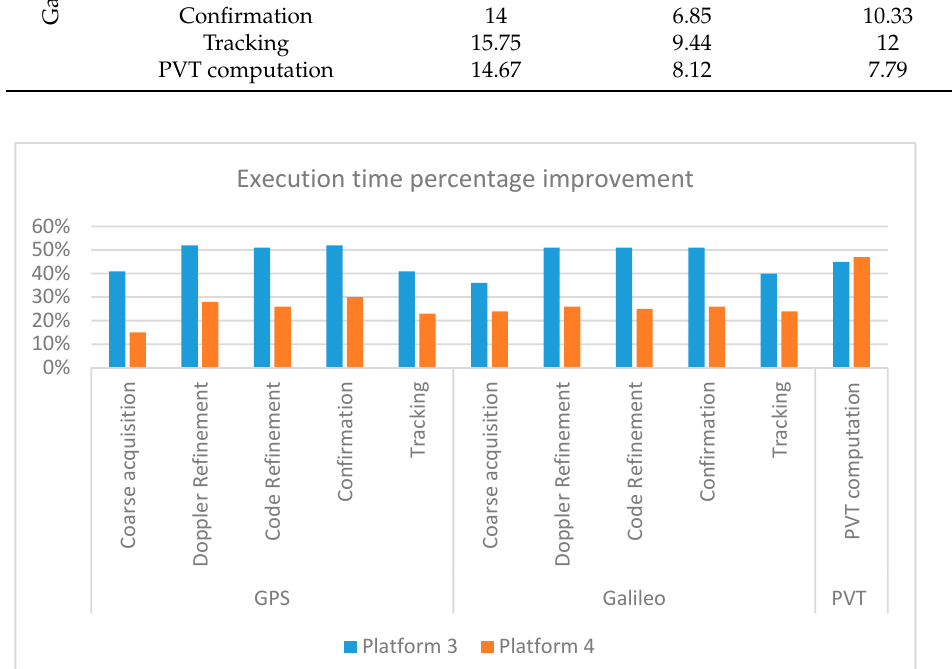
Figure 7. Execution time percentage improvement 𝐼 for platforms 3 and 4 with respect to platform 2 for all the main processing steps reported in Table 9.